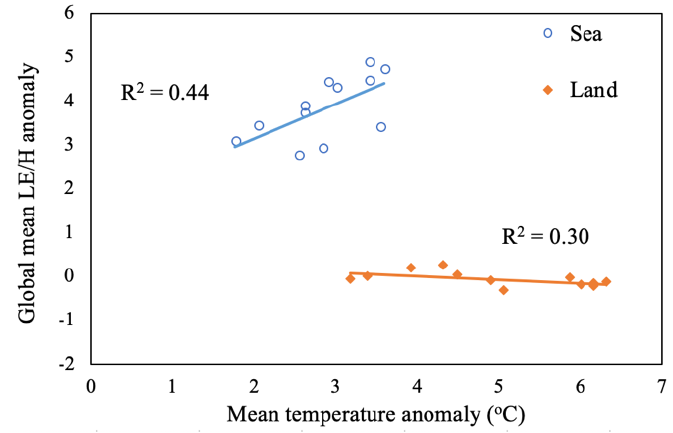
Figure 2. Anomaly of relative efficiency across the CMIP5 simulations from past to future over ( a ) sea and ( b ) land. The results between 2006 and 2100 were obtained from the RCP8.5 scenario.